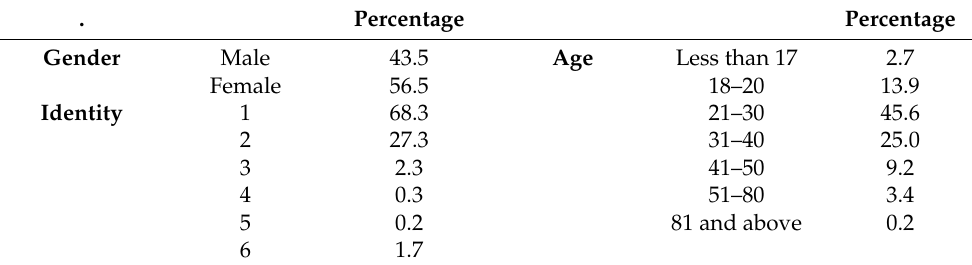
Table 1. Survey respondents’ demographic data ( N =